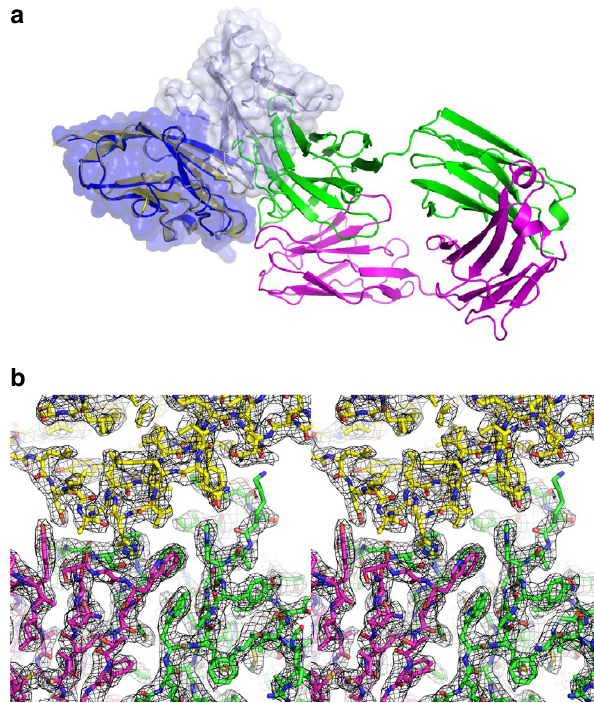
Figure 4 | Crystal structure of PD-L1 in complex with BMS-936559. ( a ) Ribbon representation of PD-L1 (yellow) in complex with BMS-936559 Fab fragment (heavy chain: green, light chain: purple). PD-1/PD-L1 complex (PDB code 4zqk) was superimposed onto the PD-L1 molecule in the complex of PD-L1/BMS-936559 with mixed ribbon/surface representation. PD-1 and PD-L1 in PD-1/PD-L1 complex are coloured pale blue and blue, respectively. The orientation of the PD-1/PD-L1 complex is same as that of Fig. 1a,c. ( b ) Stereoview of the 2fo-fc composite omit map (1.2 s contour level) at the interface between PD-L1 (yellow) and BMS-936559 (heavy chain: green, light chain: purple) calculated at 2.8Å